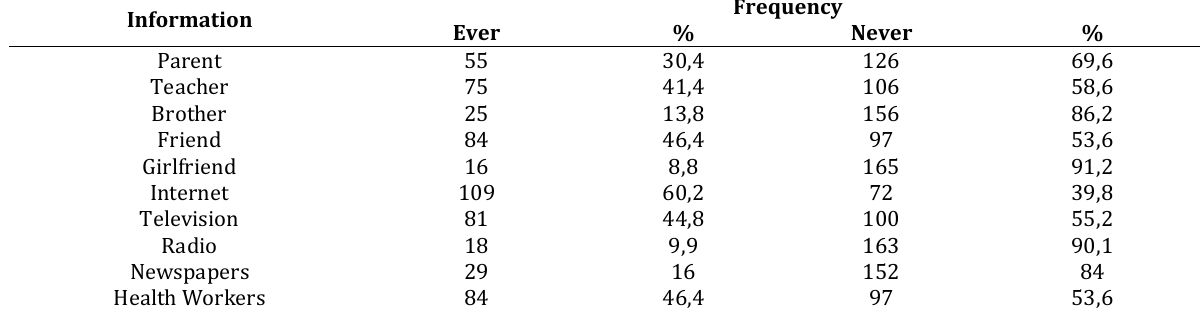
Table 2. Distribution of the Respondents Based on the Information Sources obtained by the Adolescents Information